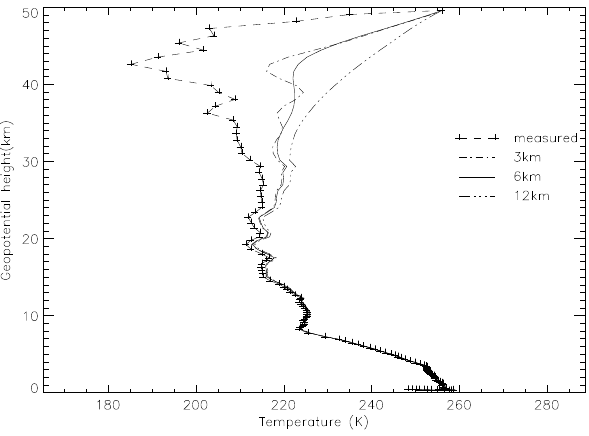
Fig. 8. The sensitivity of the temperature retrievals to the assumed correlation length for 3 km, 6 km and 12 km, using the ‘95-07-01- 02:44met-gps15’